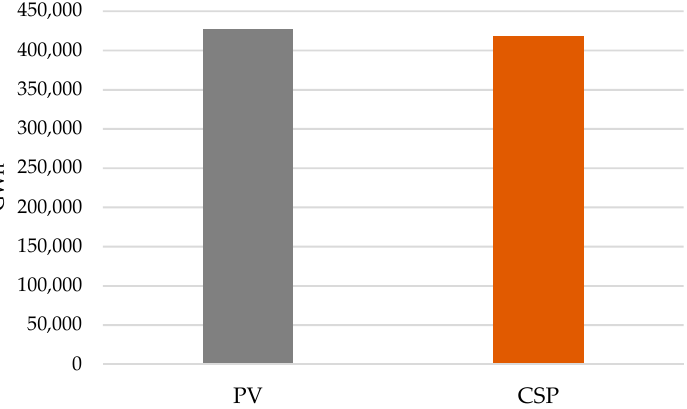
Figure 4. Comparison of the energy potential of PV and CSP in the UAE in the 25 km scenario.